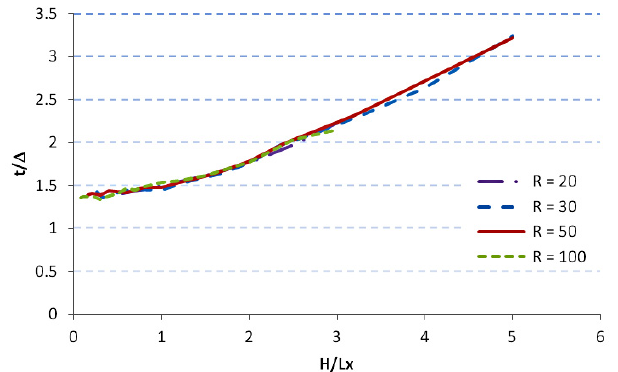
Fig. 12. Normalized uncertainty vs. normalized